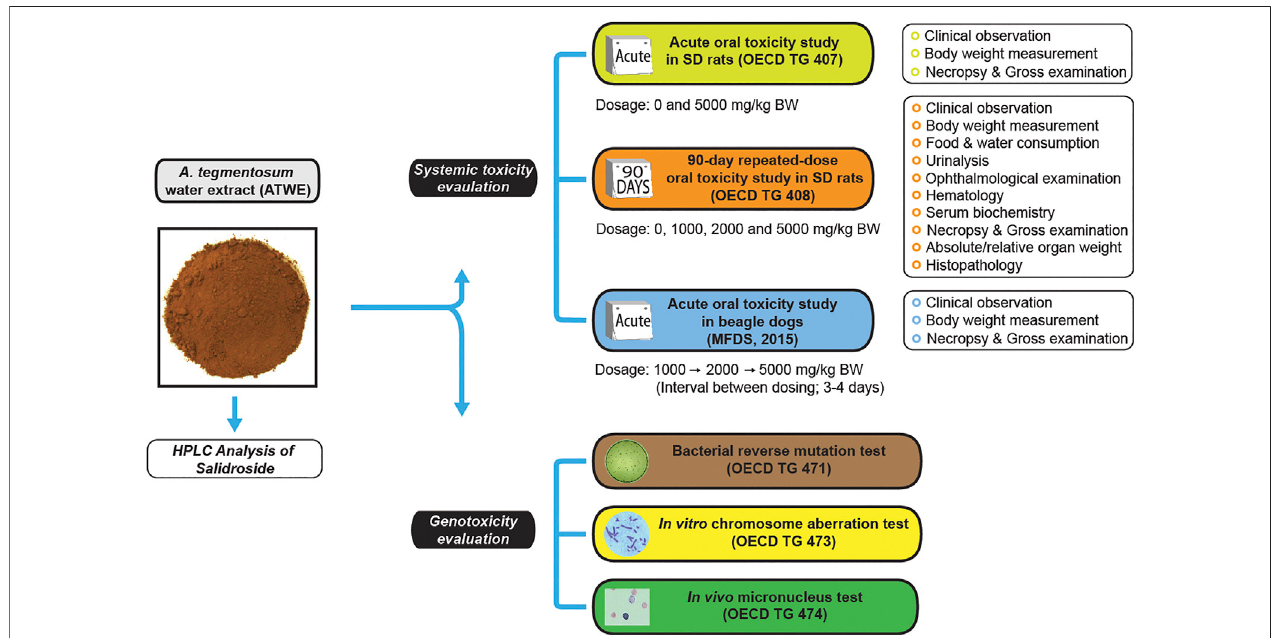
FIGURE 1 | Study design for safety evaluation of Acer tegmentosum Maxim. water extract. A schematic drawing shows the study design for systemic toxicity assessment of A. tegmentosum water extract (ATWE) from preparation and analysis, general toxicity studies for evaluation of acute and 90-day repeated-dose oral toxicity in SD rats, acute oral toxicity in beagle dogs, and genotoxicity studies for mutagenic (bacterial reverse mutation test) and clastrogenic potential ( in vitro chromosome aberration test and in vivo micronucleus test). The doses and measured parameters are given for each general toxicity study.